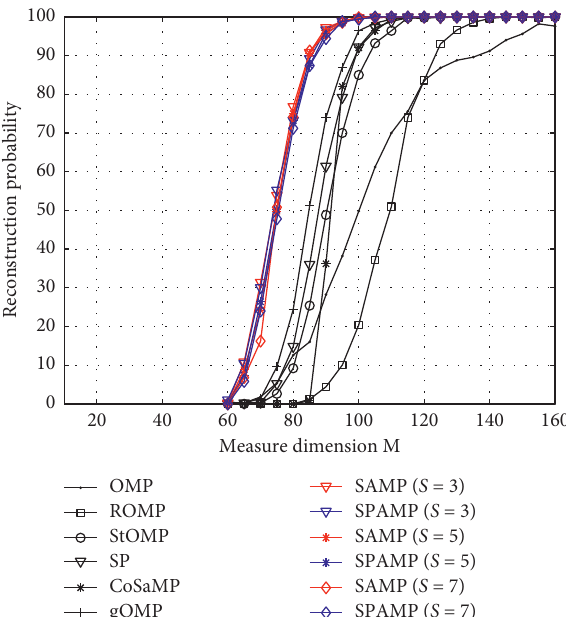
Figure 6: Probability of exact recovery versus the observation dimension ( K � 30).